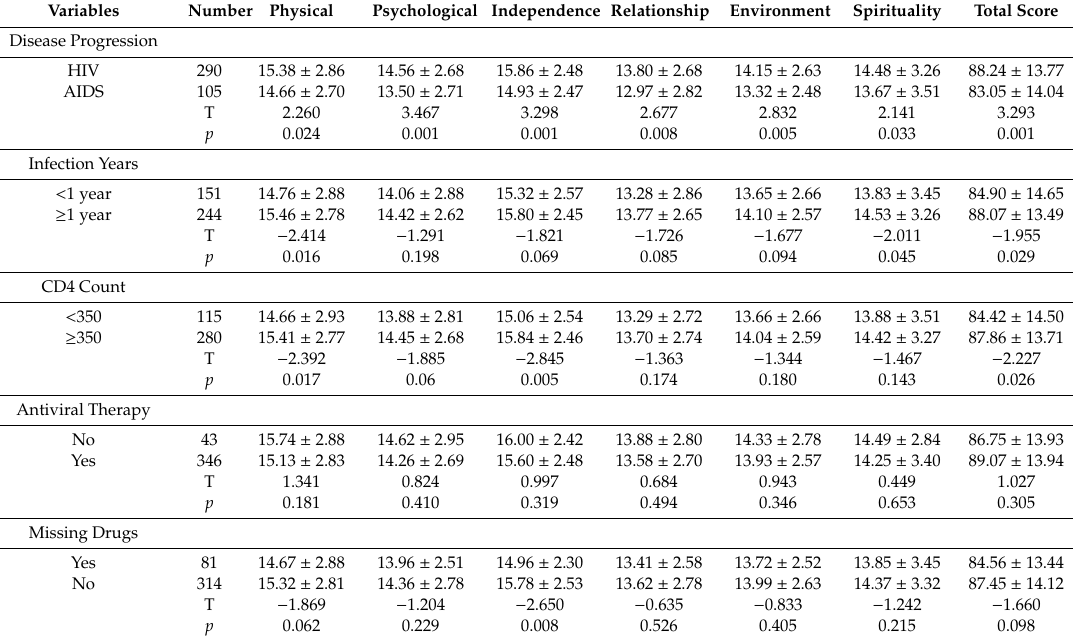
Table 4. HIV infection, antiviral therapy factors, and their relationships with quality of life ( n = 395). Variables Number Physical Psychological Independence Relationship Environment Spirituality Total Score Disease Progression HIV